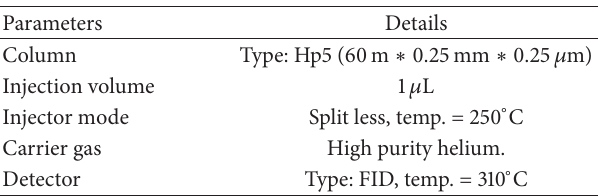
Table 2: Chromatographic conditions were used for determination Anthracene by GC.